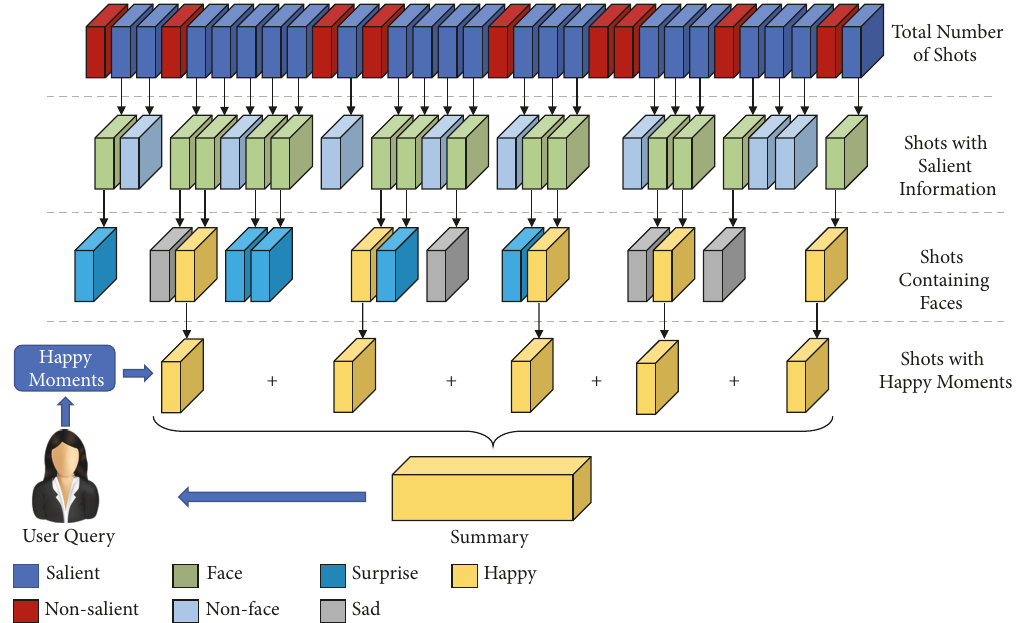
Figure 4: Flow diagram of summary generation based on